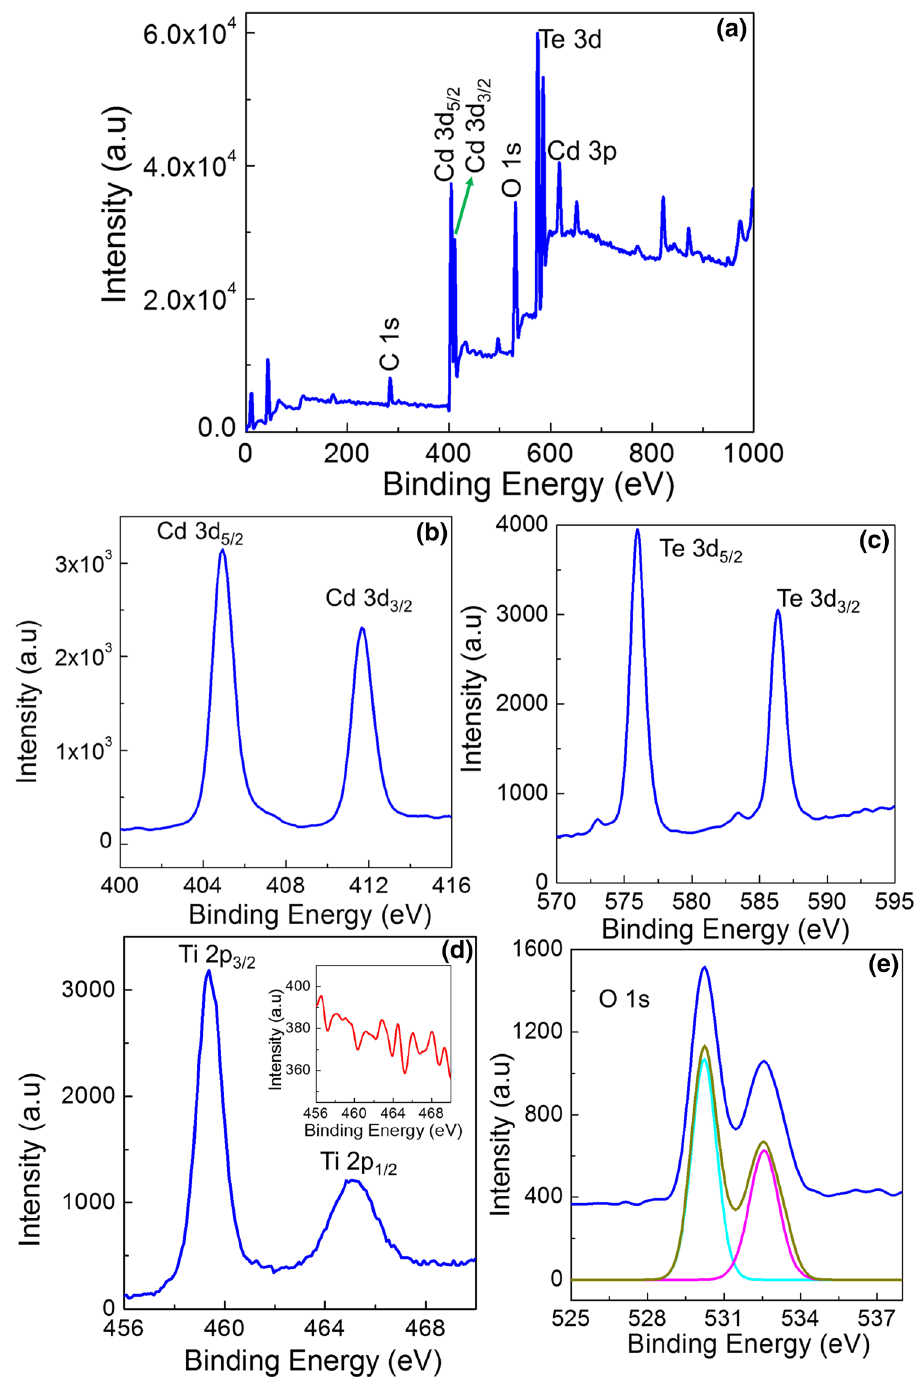
Fig. 1 a XPS survey spec- trum showing Cd 3d, Te 3d, and O 1 s obtained from the heterogeneous film. b and c High-resolution scans of Cd 3d and Te 3d, respectively. d and e High-resolution XPS scans of Ti 2p (inset shows no Ti 2p due to CdTe on TiO 2 ) and O 1s,